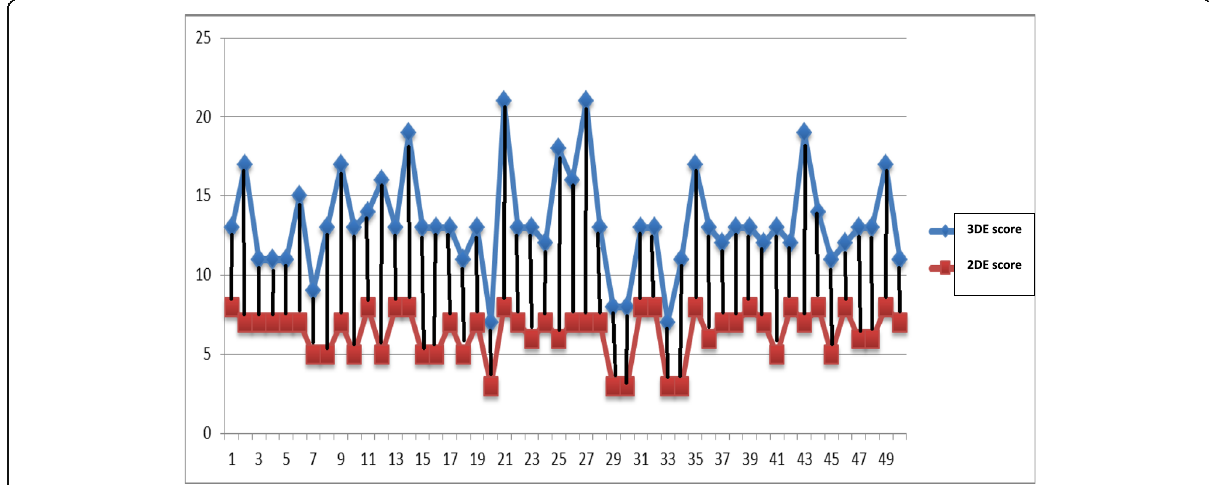
Fig. 2 Pre-procedural 2D-Wilkins score and 3D-Anwar score in each